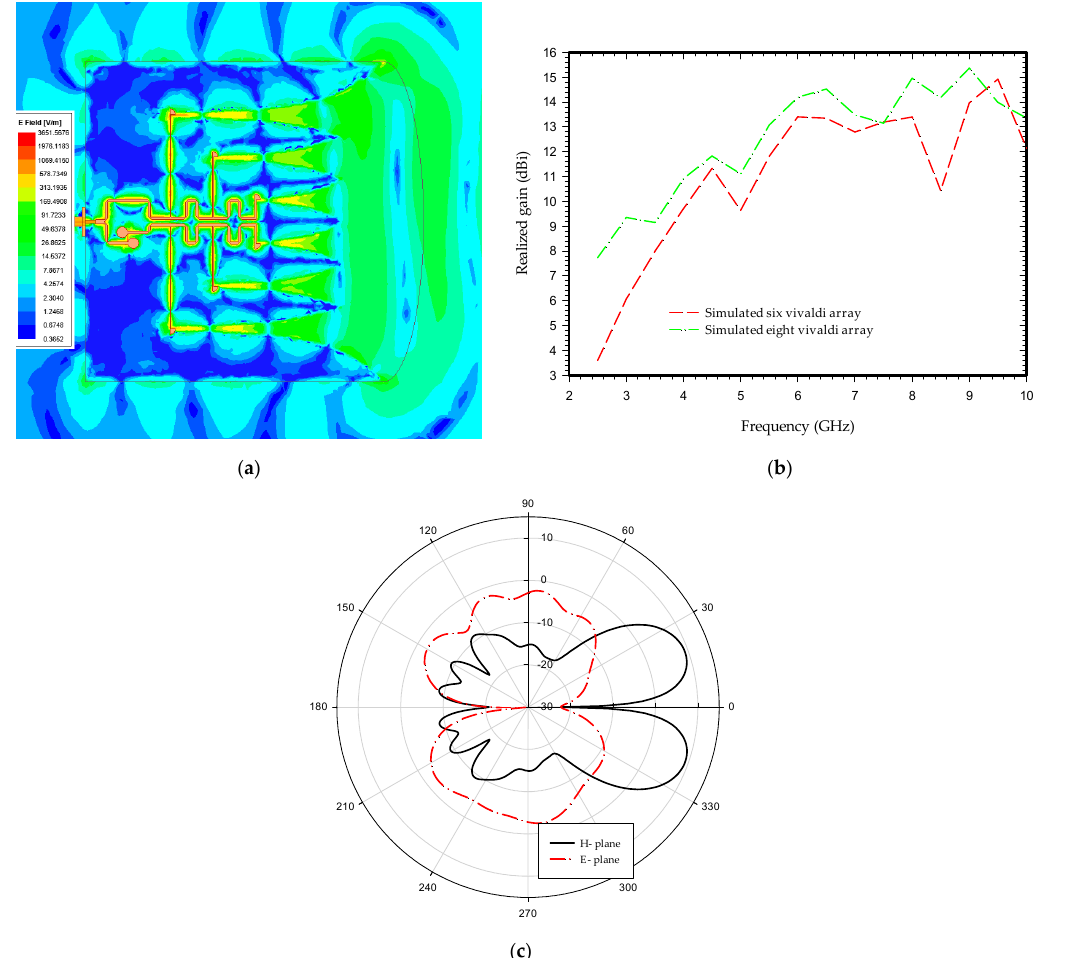
Figure 6. Simulated electric field, gain, and radiation pattern of the antenna: ( a ) electric field distribution at 4.5 GHz; ( b ) simulated realized gain of six and eight Vivaldi antennas array; ( c ) simulated radiation pattern at 4.5 GHz without phase shifter.